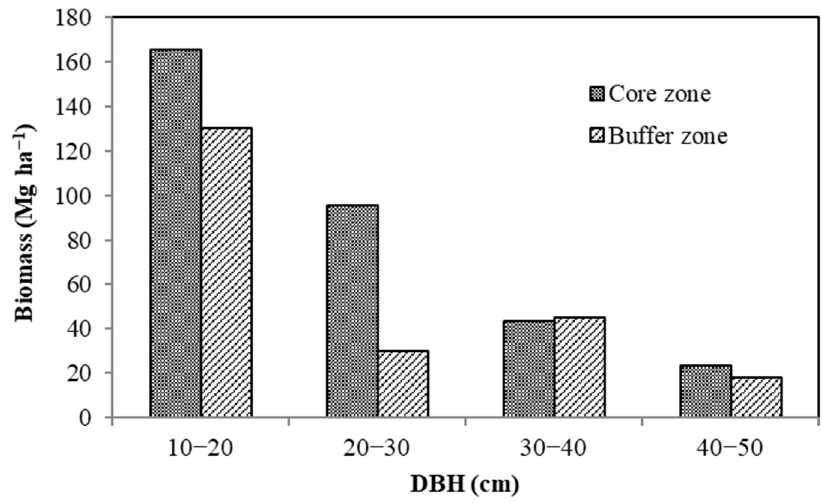
Figure 5. Tree biomass distribution in various DBH classes for the core and buffer zones in Minkong Community Forest Reserve, Nagaland, India.